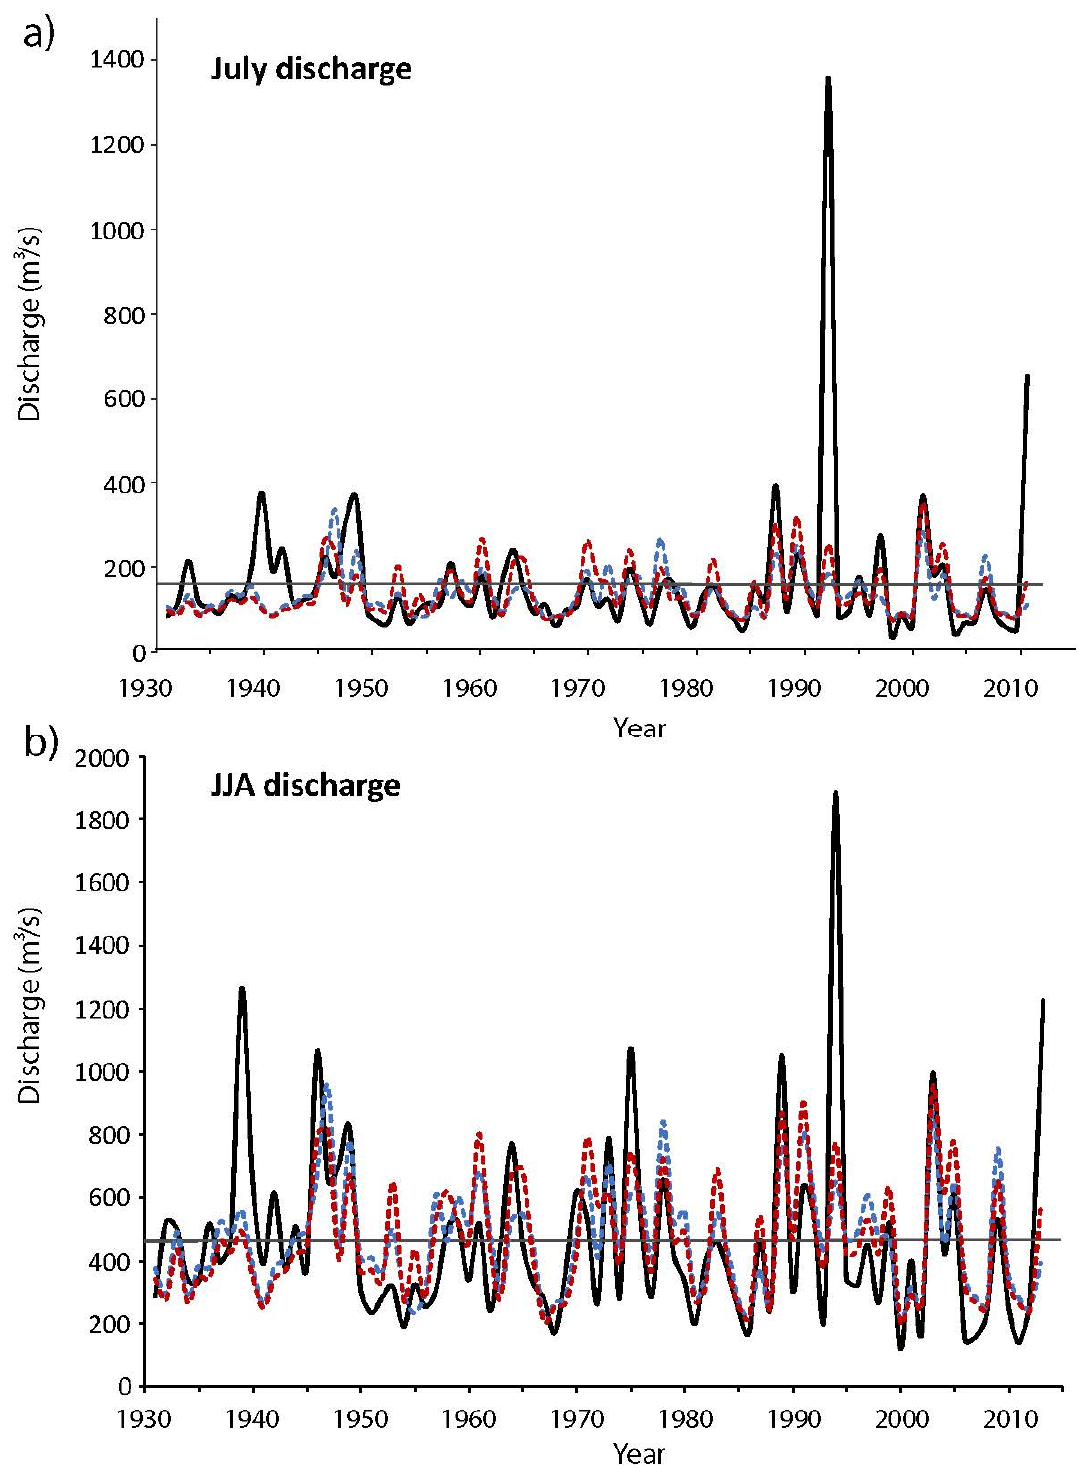
Figure A2. Shows the same data as Figure 8 (observed ( thick black line ), total ring width-modeled ( blue dashed line ), total ring width + FR b -modeled ( red dashed line ) and observed mean discharge ( horizontal black line ) for ( a ) July and ( b ) total JJA discharge), but shows the full range of all values. Note the extreme values in 1994 and 2013 caused by rainfall associated with Tropical Storms “Alberto” and “Andrea” respectively.